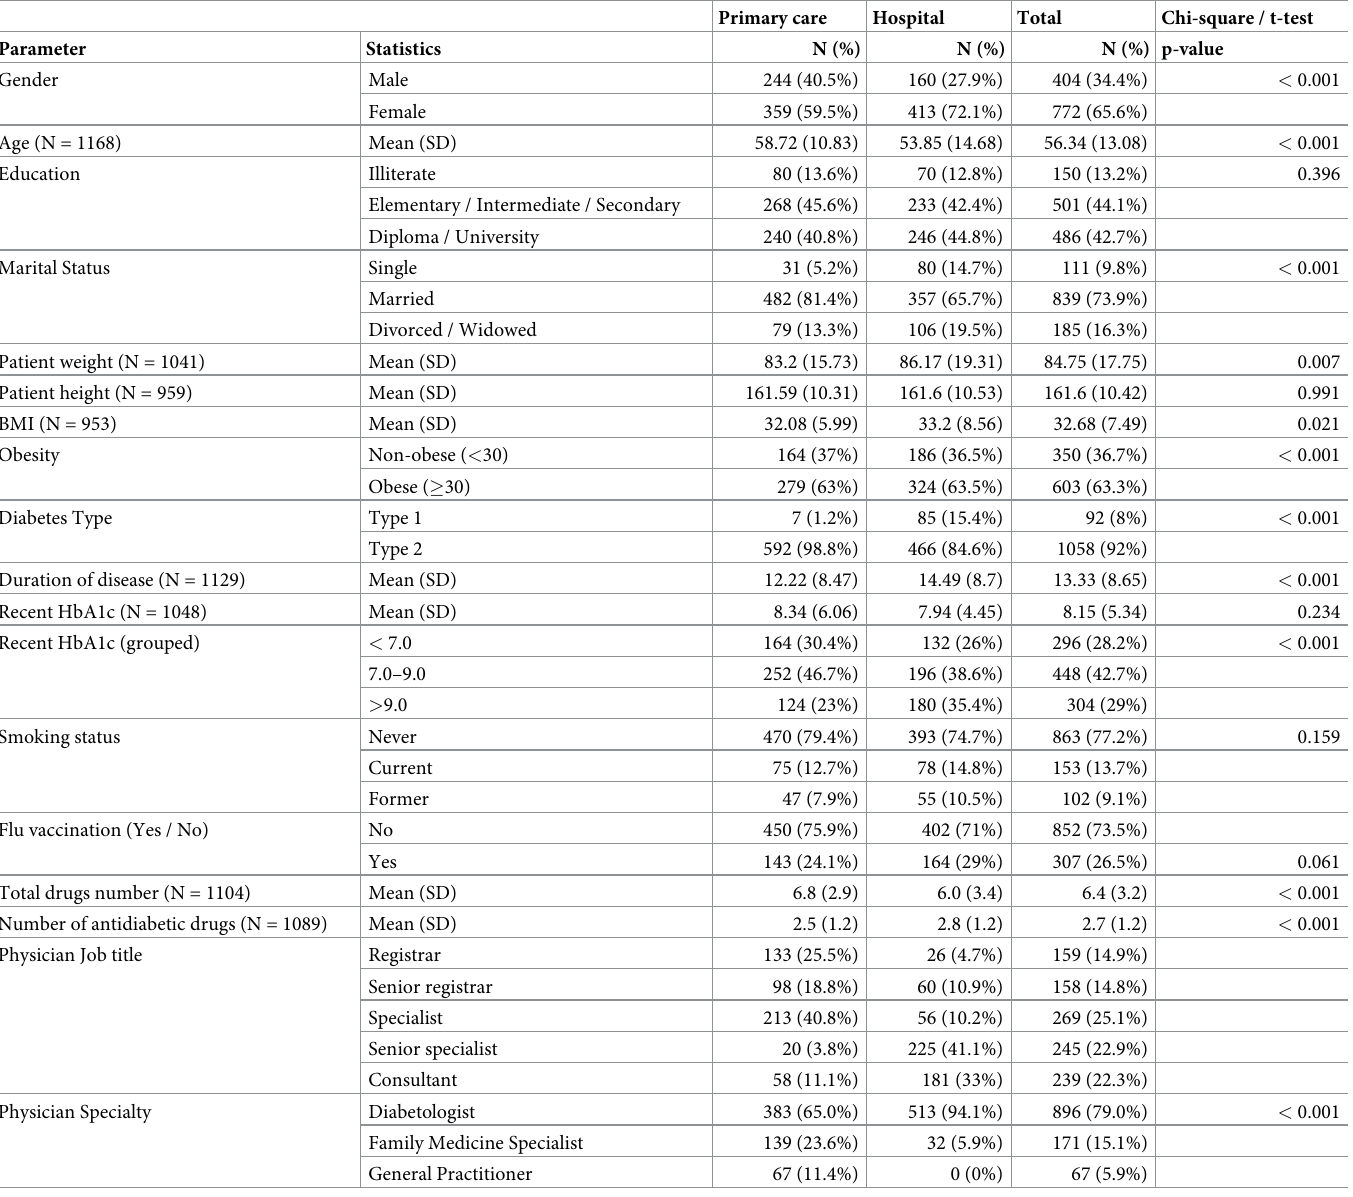
Table 2. Patient demographics by facility